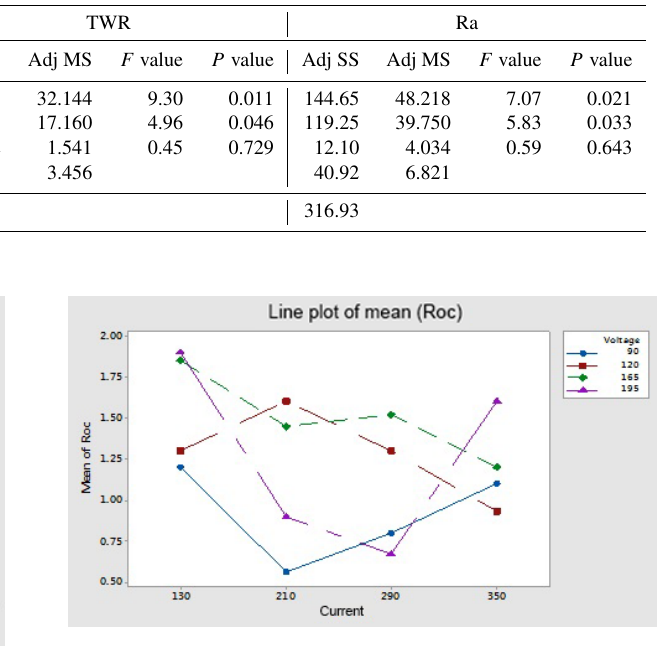
Figure 9. Current and voltage relation of OC for the non-cryogenic